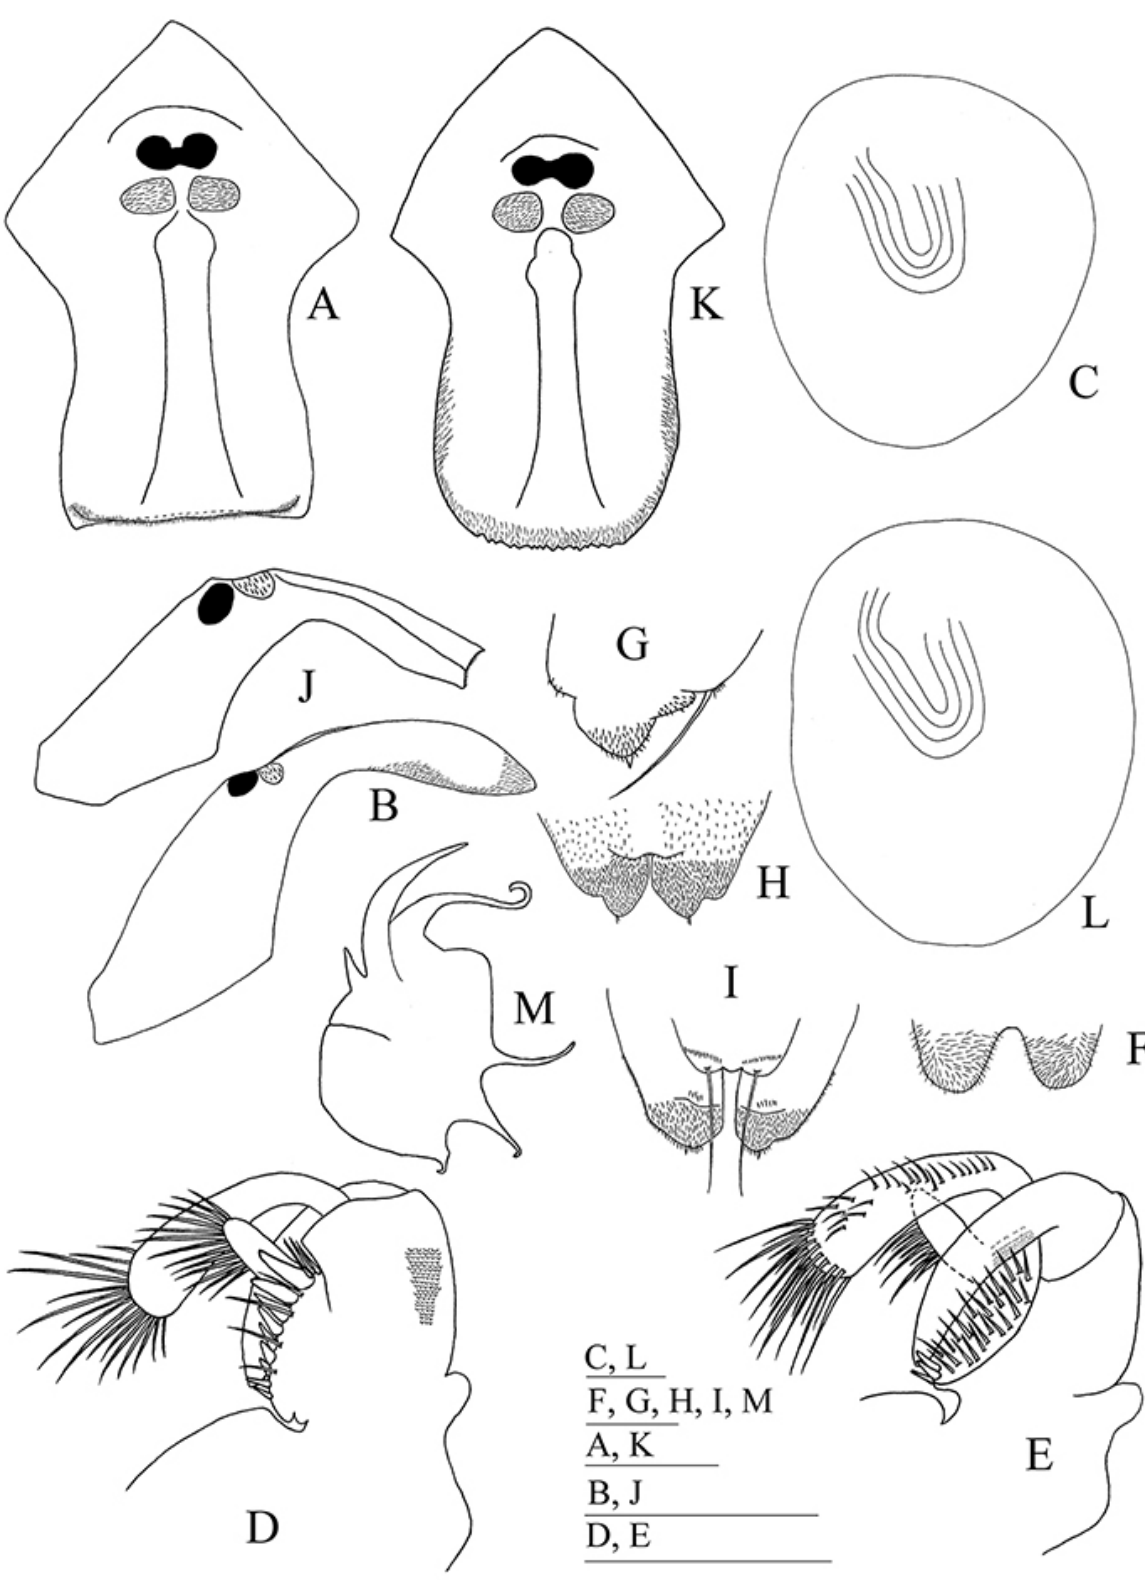
Figure 1. Line drawings of Lynceus grossipedia n. sp., A–G: male, H–M: female. A. Head, anterior view. B. Head, left lateral view. C. Carapace, left lateral view. D. Left clasper, posterior view. E. Right clasper, anterior view. F. Opercular lamella, ventral view. G. Telson, left lateral view. H. Telson, ventral view. I. Telson, dorsal view. J. Head, left lateral view. K. Head, anterior view. L. Carapace, left lateral view. M. Lamina abdominalis, left lateral view. Scale bars 1